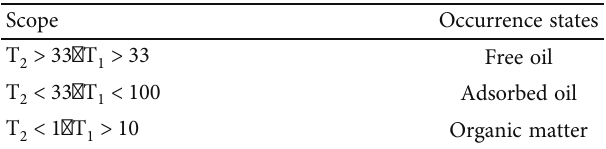
Table 4: Displacement e ff ect of parallel rock samples under di ff erent